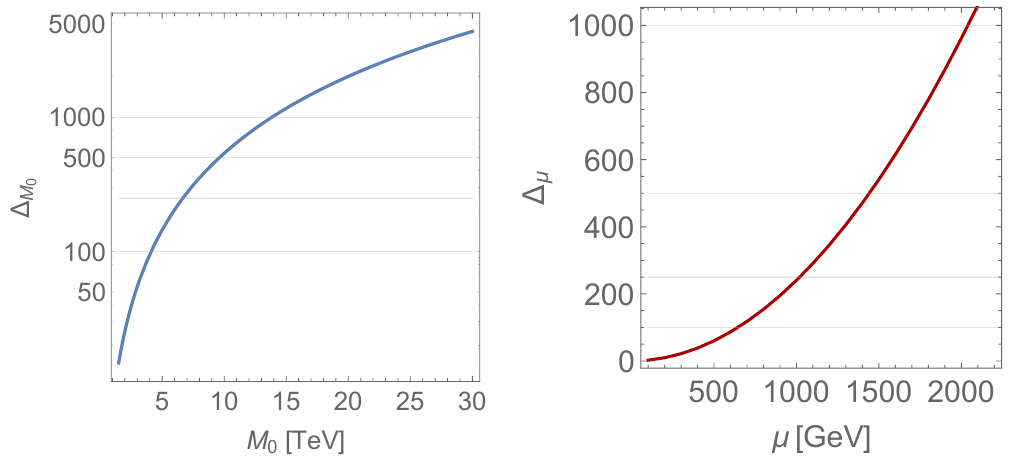
Figure 1 . Degrees of tuning of M 0 (left) and (cid:22) (right). The gray lines correspond to (cid:1) M 100 ; 250 ; 500 ; 1000 from bottom to